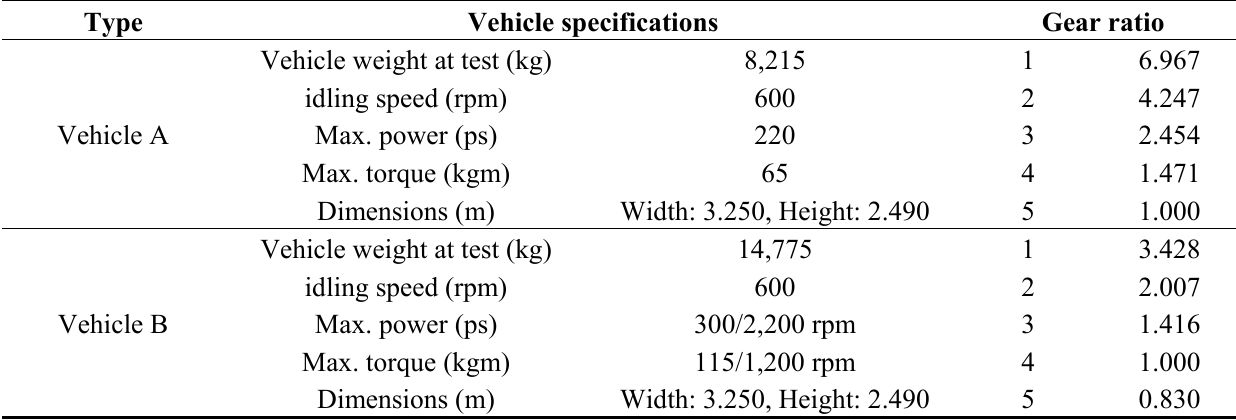
Table 4. Specifications of HDVs implemented in the fuel efficiency test.